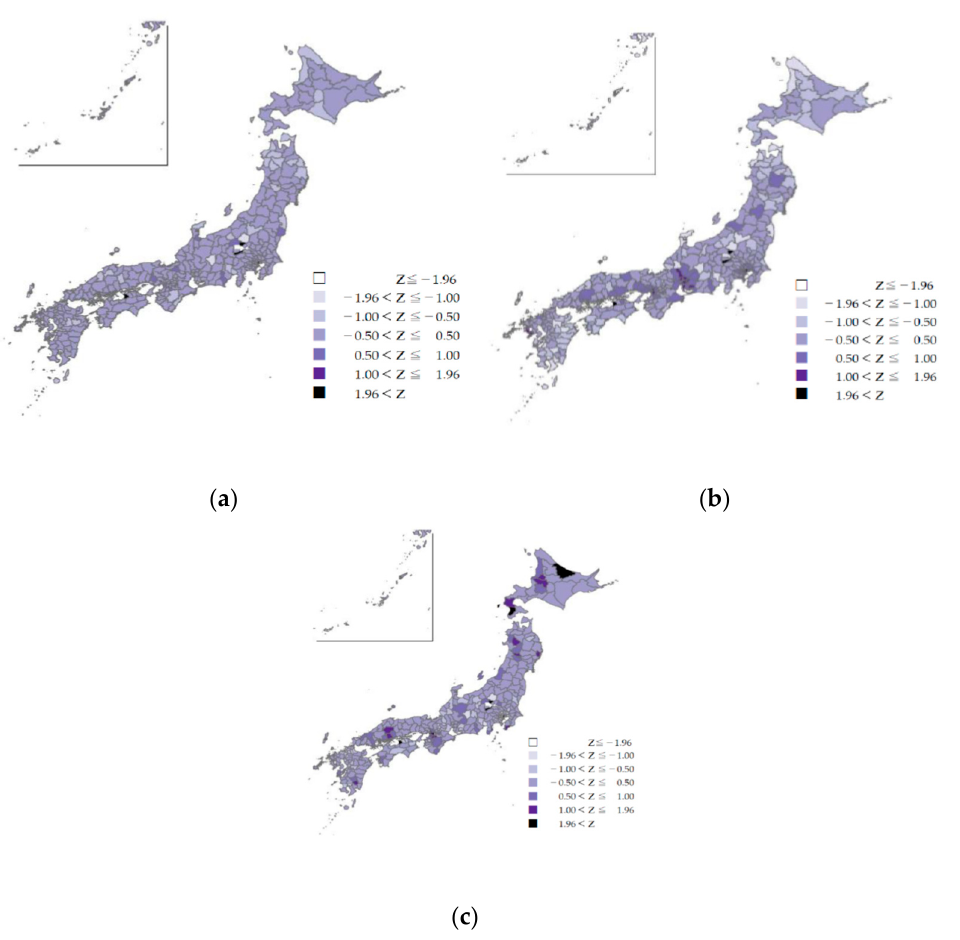
Figure 4. ( a ) The z-scores of dental caries by secondary medical areas in Japan, FY2018. ( b ) The z-scores of periodontal diseases by secondary medical areas in Japan, FY2018. ( c ) The z-scores of tooth loss by secondary medical areas in Japan, FY2018.